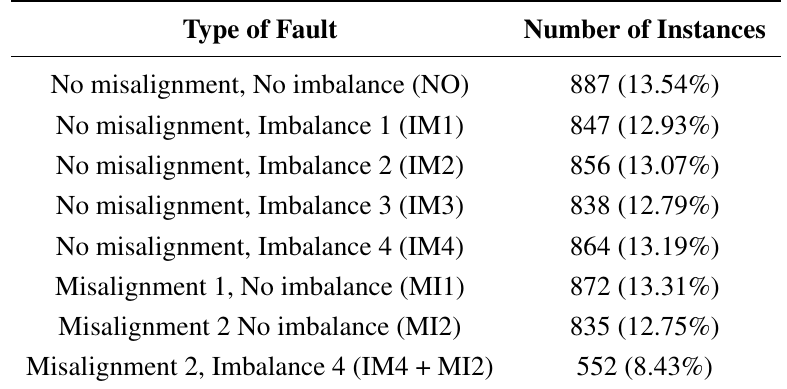
Table 3. Distribution of measurements between the different instances of failures that were tested.